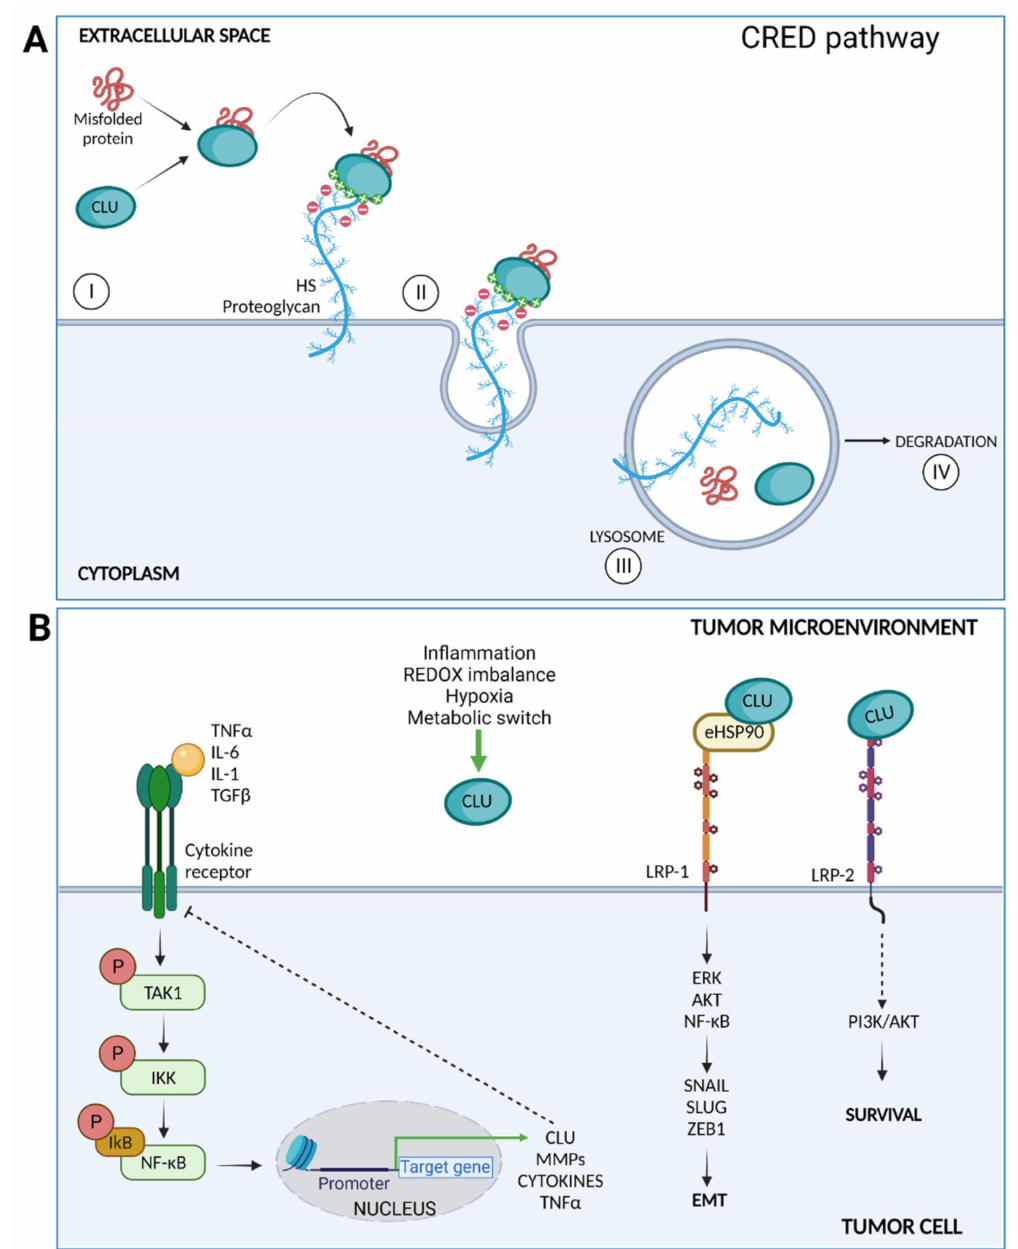
Figure 3. ( A ) CLU mediates clearance of misfolded proteins through the chaperone- and receptor-mediated extracellular protein degradation (CRED) pathway. CLU binds a misfolded protein and then interacts with the HS chains membrane PGs by electrostatic interactions (I); the CLU–client protein-receptor is endocytosed (II) and delivered to the lysosome (III) for intracellular degradation (IV). ( B ) Intracellular signaling pathways triggered by CLU after surface receptors binding. CLU inhibits the TAK1– NF- κ B signaling axis triggered by inflammatory cytokines. CLU facilitates eHSP90 binding to LRP1, enhancing the activation of ERK, AKT, and NF- κ B and promoting EMT. Finally, CLU binds LRP2 and promotes cell survival through PI3K/AKT